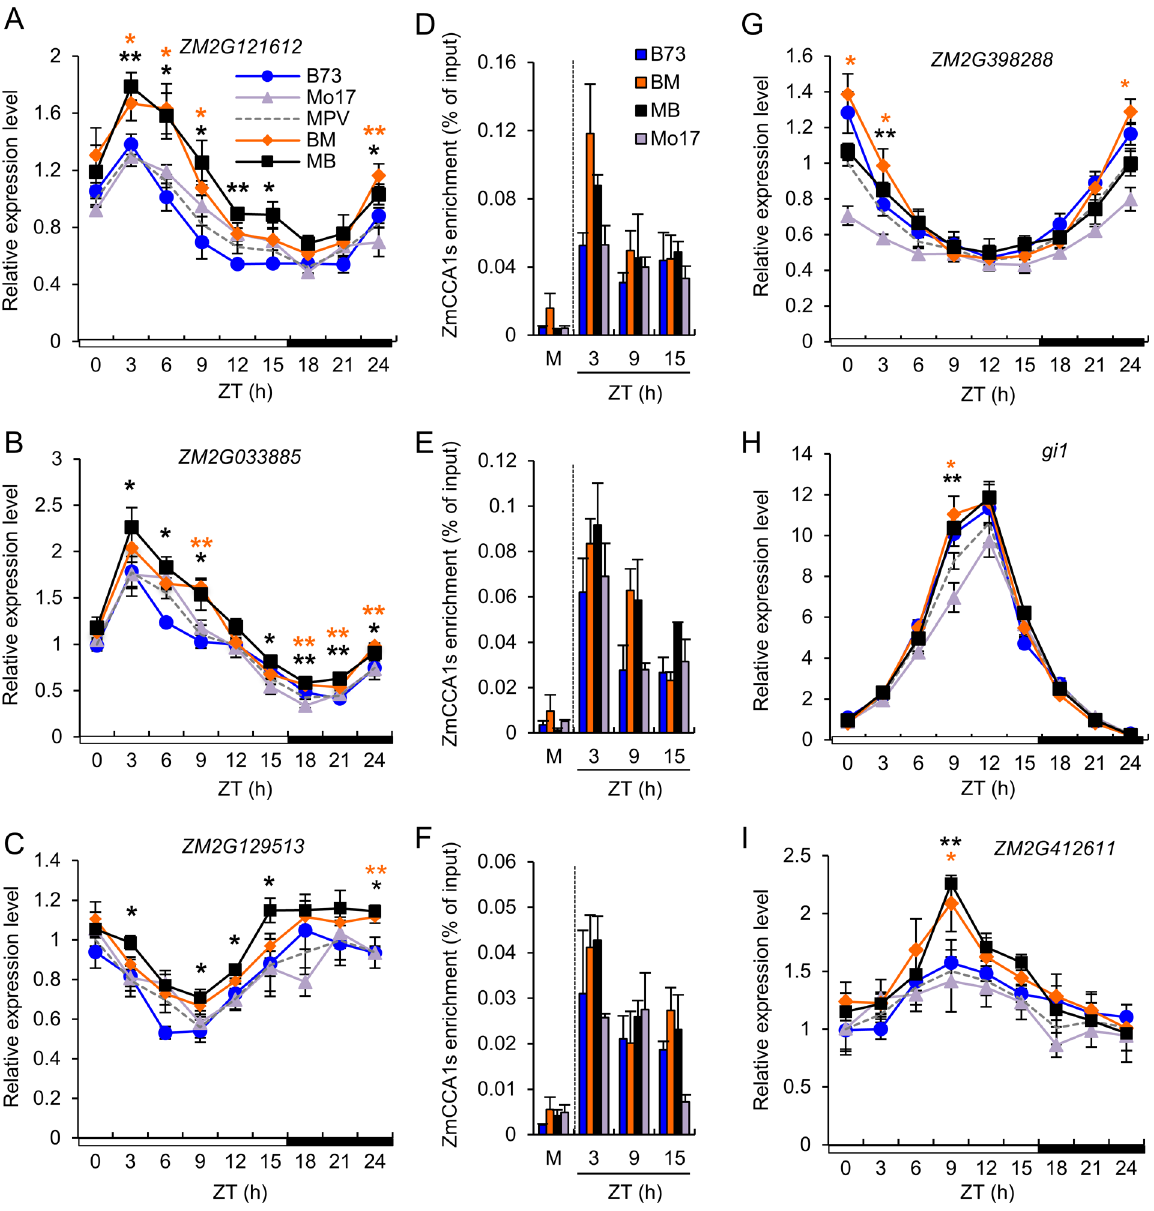
Fig 6. Diurnal expression of ZmCCA1-binding target (carbon fixation) genes in response to the phase-shift of ZmCCA1-binding in the hybrids. (A-C and G) Relative expression levels (means ± SEM, n = 3) of the morning-phased carbon fixation genes, including ZM2G121612 (A), ZM2G033885 (B), ZM2G129513 (C) and ZM2G398288 (G), every 3 hours in a 24-hour period (light/dark cycle is shown below the histogram). The relative expression level in MPV at ZT0 was set to 1. Significant difference between hybrids and MPV was calculated using Student ’ s t-test, * p-value < 0.05 and ** p-value < 0.01 (D-F) ChIP-qPCR validation of ZmCCA1s ChIP enrichments on ZM2G121612 (D), ZM2G033885 (E) and ZM2G129513 (F). M indicates the enrichment in mock samples at ZT3. The EMSA analysis confirmed ZmCCA1b-bining to the promoter of ZM2G121612 , ZM2G033885 and ZM2G129513 in vitro (S9 Fig). (H-I) Relative expression levels (means ± SEM, n = 3) of the afternoon-phased genes, gi1 (H) and ZM2G412611 (I), every 3 hours in a 24-hour period (light/dark cycle is shown below the histogram). The relative expression level in MPV at ZT0 was set to 1. Significant difference between hybrids and MPV was calculated using Student ’ s t-test, * p-value < 0.05 and ** p-value <